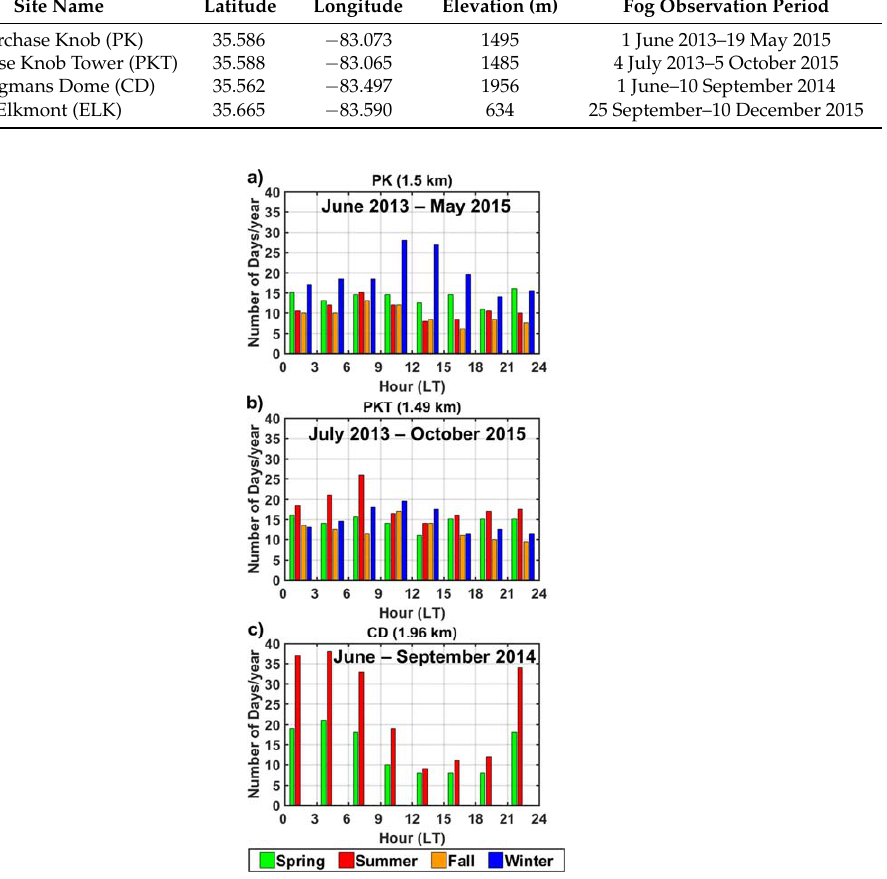
Table 1. Descriptions of the fog collectors and their deployment periods in the Southern Appalachian Mountains (SAM).